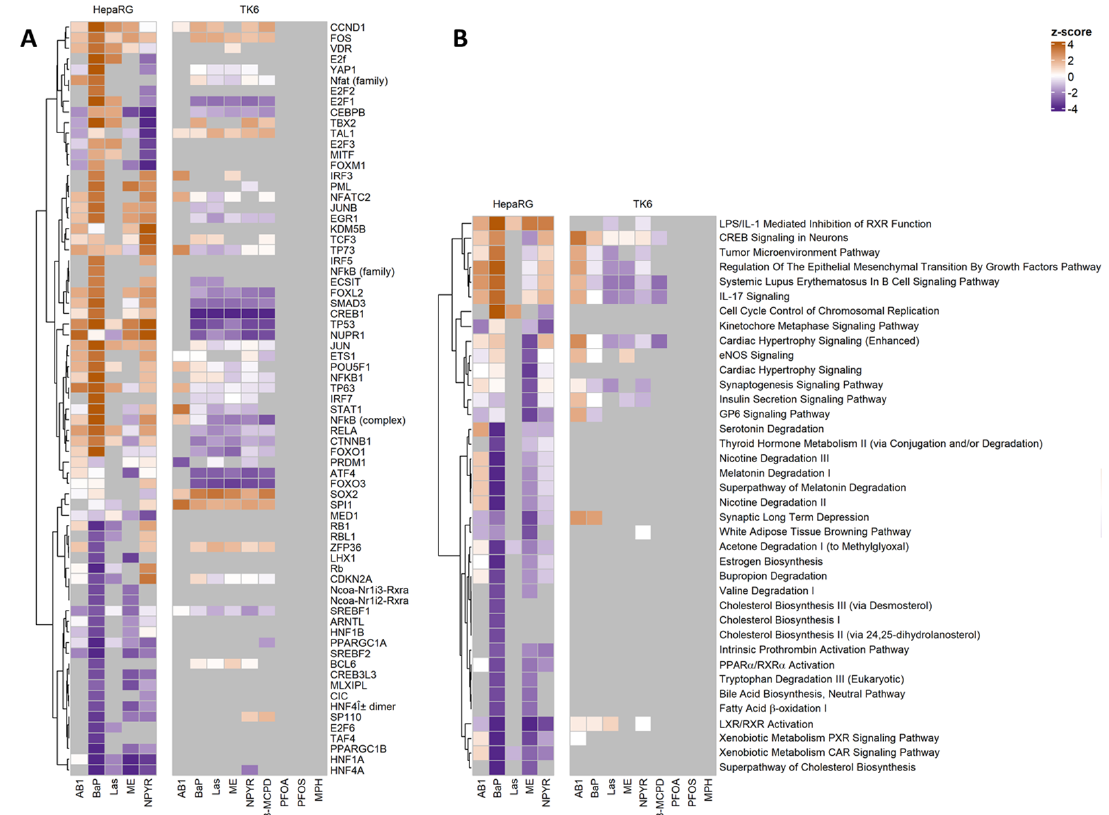
Figure 4. Prediction results by Ingenuity Pathway Analysis (IPA). A bioinformatic analysis with IPA indicates transcriptional factors and pathways possibly associated with the DEGs measured by RNA sequencing. In a previous study, we performed RNA sequencing in the liver cell model HepaRG with five genotoxic agents, which we have now extended to the lymphoblastoid TK6 cell model with additional non-genotoxic agents. These data from the HepaRG and TK6 models were analyzed here together using IPA software. RNA sequencing with HepaRG cells was described in Kreuzer et al. [14]. ( A ) IPA results for “upstream regulators”. The “upstream regulators” were filtered to include only transcriptional regulators. The z-score ≥ 2 or ≤− 2 predicts a significantly activated or inhibited transcriptional regulator state, respectively. ( B ) IPA results for the “canonical pathways”. The z-score ≥ 2 or ≤− 2 predicts a significantly activated or inhibited pathway,